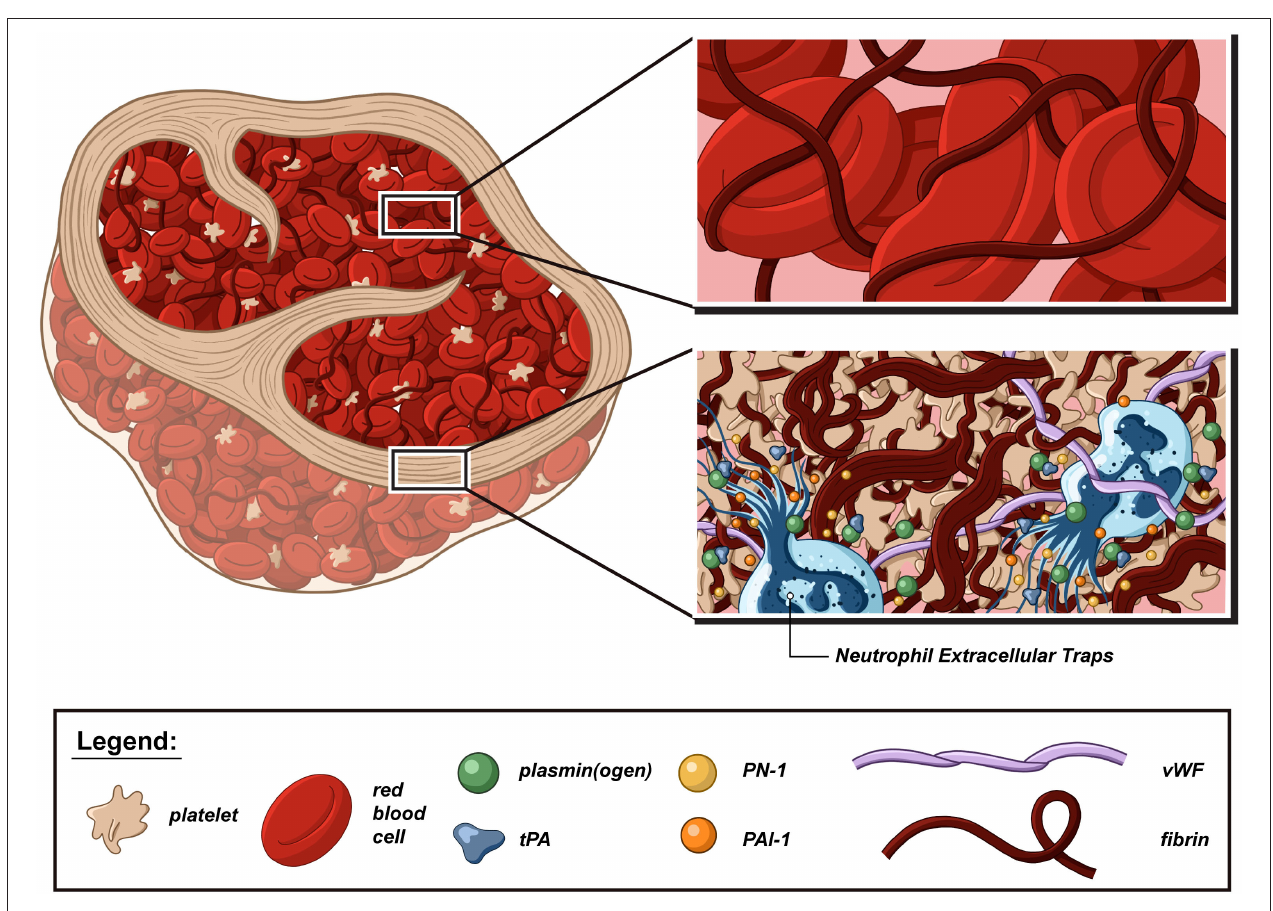
FIGURE 1 | Schematic representation of a thrombolysis resistant acute ischemic stroke thrombus. Although acute ischemic stroke (AIS) thrombi are highly variable in size, shape, and cell proportion, they share the same basic fibrillar and cellular components, and organization domains. There is converging evidence that platelets, neutrophils, von Willebrand factor (vWF), and neutrophil extracellular traps (NETs) form thrombolysis-resistant microdomains that are notably characterized by a higher degree of fibrin compaction and increased content in fibrinolysis inhibitors, such as plasminogen activator inhibitor-1 (PAI-1) and protease nexin-1 (PN-1). In contrast, the fibrin network is looser in red blood cell-rich areas and can be further loosened via the combined action of tissue-type plasminogen activator (tPA) and